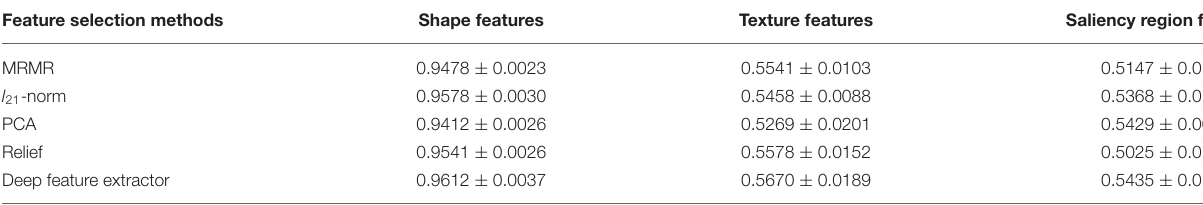
TABLE 4 | Classification performance in terms of sensitivity.